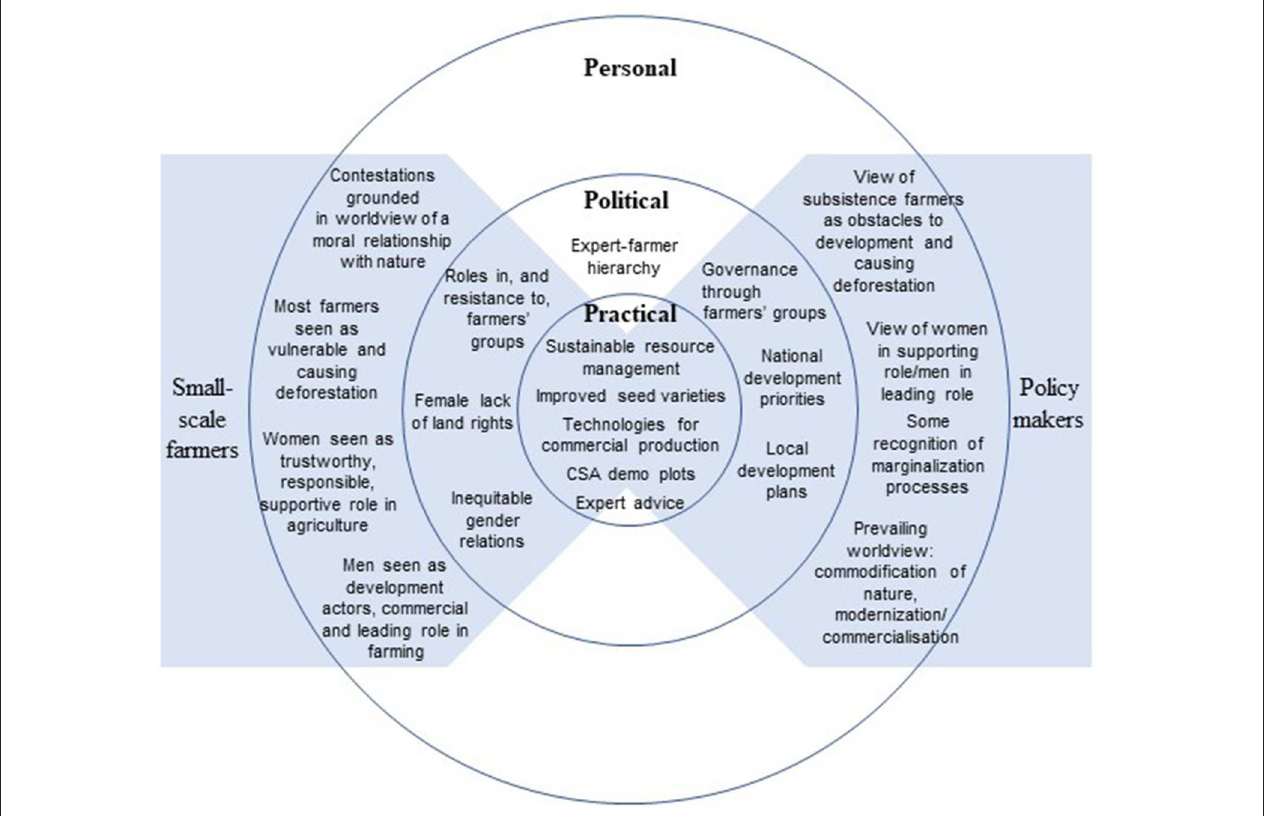
FIGURE 4 | Aspects of interactions and contestations across spheres of transformations observed in Hoima. Source: Authors’ adaptation of framework from O’Brien and Sygna (2013)